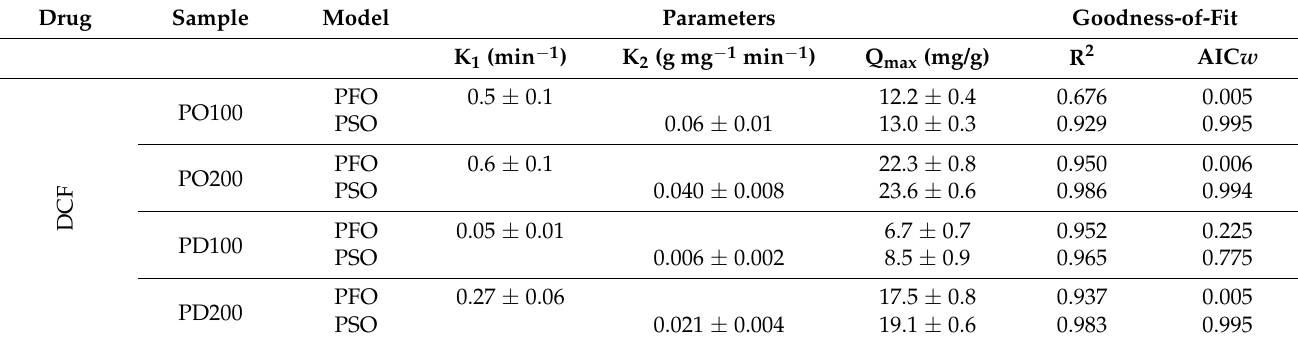
Table 4. Mathematical models of kinetic runs: parameters and